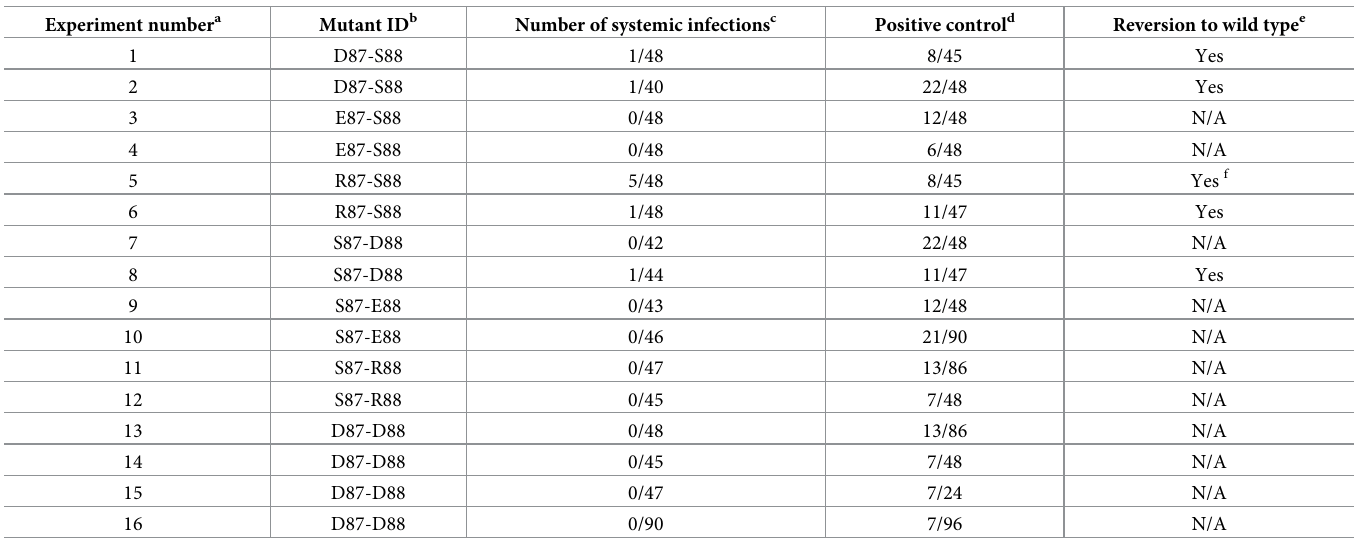
Table 3. Infectivity of CP mutants of